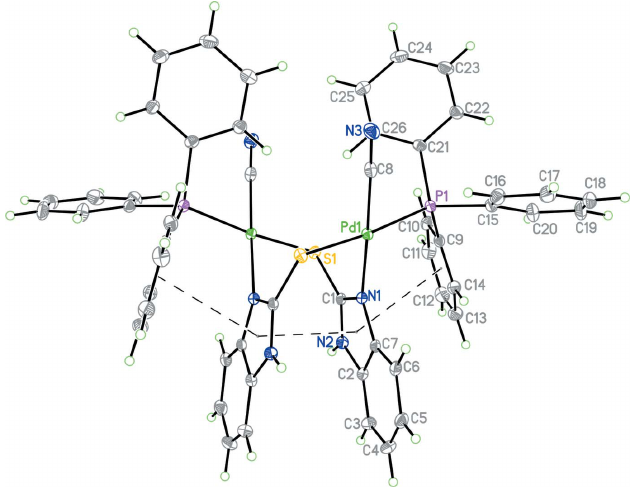
Figure 1 Diagram of 1 showing the atom labeling for unique atoms (the molecule lies of a twofold axis; symmetry operation to generate the rest of the (cid:3) z ) and the strong intramolecular (cid:4) – (cid:4) interactions molecule is (cid:3) x , y , 1 2 involving both the thione rings and adjacent phenyl rings from the triphenylphosphine ligand. Atomic displacement parameters are at the 30% probability